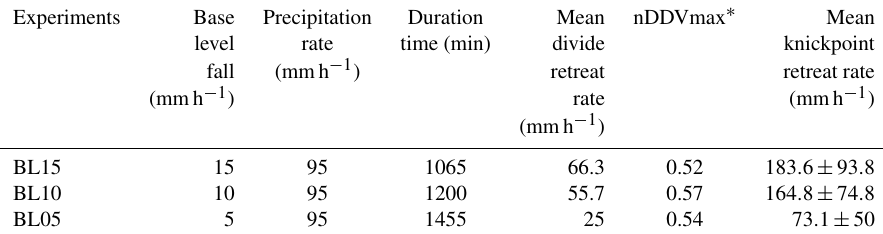
Table 1. Parameters of experiments.